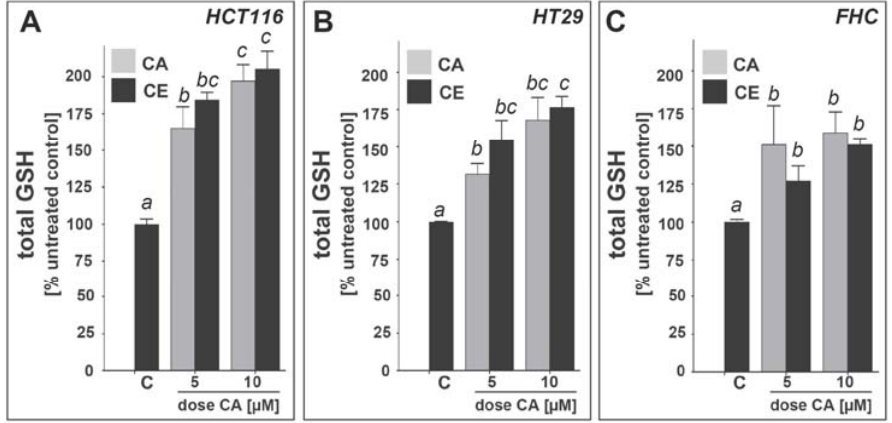
Figure 6. Upregulation of cellular glutathione levels in cultured human colon cells exposed to cinnamic aldehyde and ethanolic cinnamon extract. Modulation of intracellular glutathione content in HCT116 (panel a ), HT29 (panel b), and FHC cells (panel c) was examined after exposure to CA (5 and 10 µM, 24 h) or CE (dose CA: 5 and 10 µM). Total glutathione content was normalized to protein content and expressed as % untreated control. (mean ± SEM, n = 3; means with common letter differ, p <